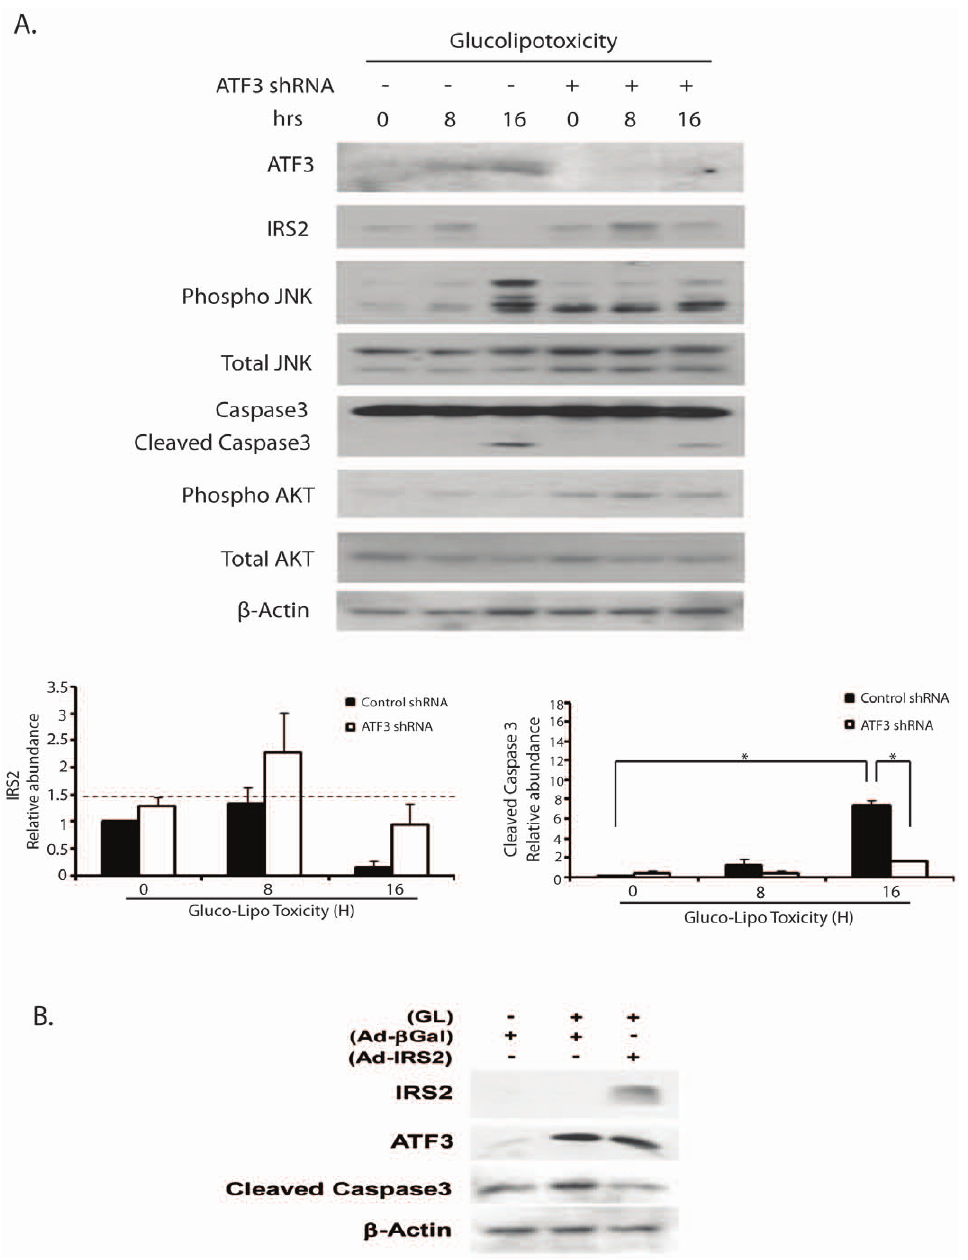
Figure 6. Loss-of-function of ATF3 and gain-of function of IRS2 reduce the effects of glucose and palmitate on apoptosis. ( A ) INS-r3 cells were infected with either control or ATF3 shRNA adenovirus 24-h prior to treatment with 400 m M palmitate + 0.5% BSA and 25 mM glucose for the indicated times. Total cell lysates were obtained and subjected to Western blot analysis with antibodies to the indicated proteins. The relative ratio of IRS2 and cleaved Caspase3 expression over b -Actin was quantified by densitometry. The data obtained from three individual experiments are expressed as means 6 S.E.M. * p , 0.02, ** p , 0.012. ( B ) In a single experiment, primary mouse islets were infected with adenovirus expressing b gal or IRS2 expressing adenovirus prior to treatment with either control 0.5% BSA and 5.5 mM glucose or 400 m M palmitate + 0.5% BSA and 25 mM glucose for 72-h. ‘‘GL’’ refers to incubation in 25 mM glucose and 400 m M palmitate. Total cell lysates were subjected to Western blot using antibodies to indicated